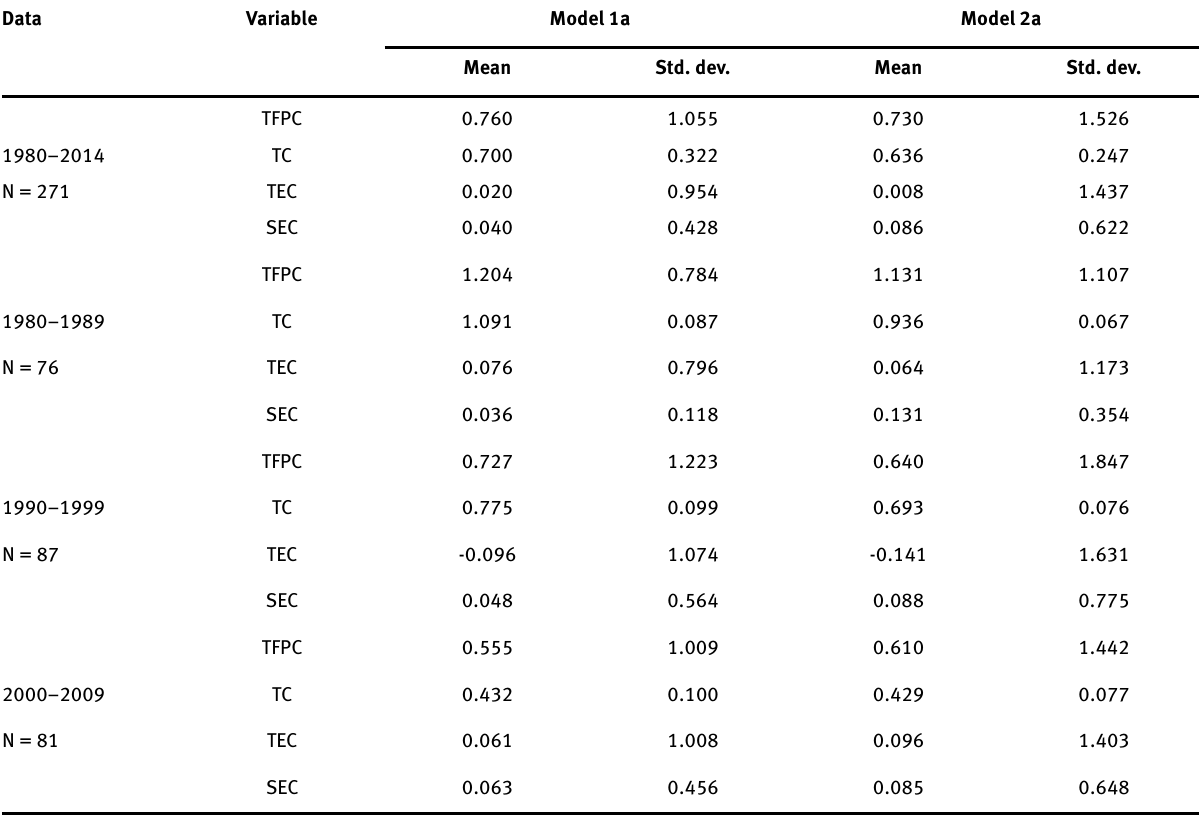
Table 4: Summary of TFP change using two estimated stochastic frontiers Data